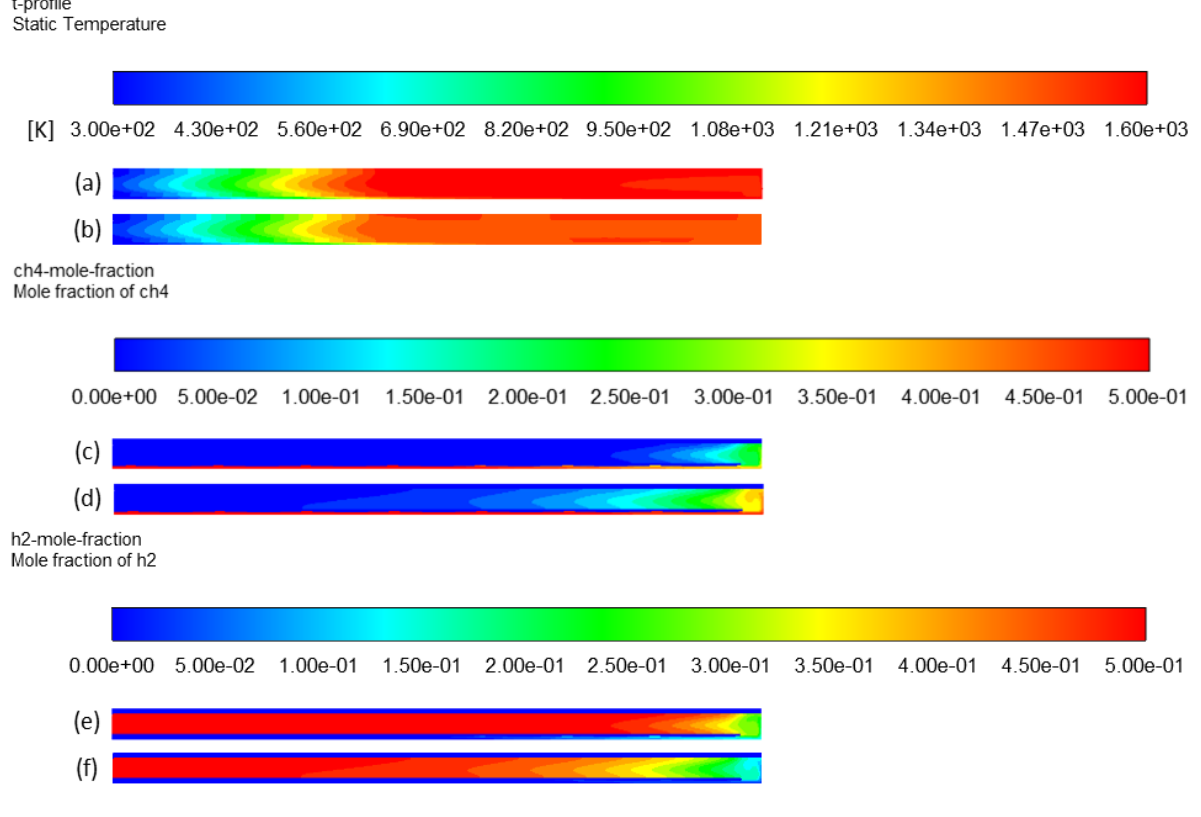
Figure 14. Effect of heating temperature on temperature profile: ( a ) case 5 and ( b ) case 1; CH 4 mole fraction profile: ( c ) case 5 and ( d ) case 1; H 2 mole fraction profile: ( e ) case 5 and ( f ) case 1.